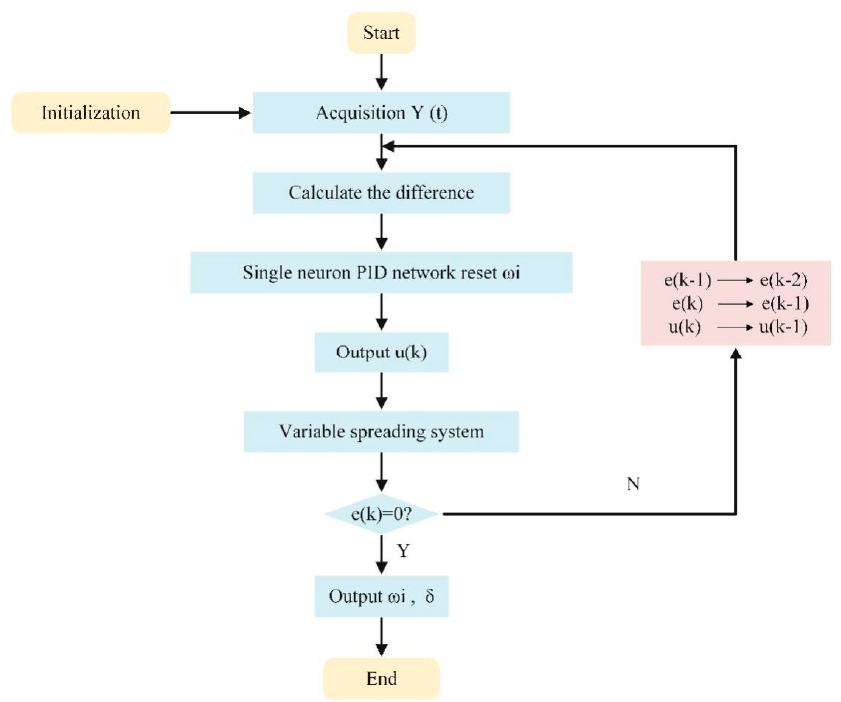
Figure 6. SNPID control algorithm flow chart .